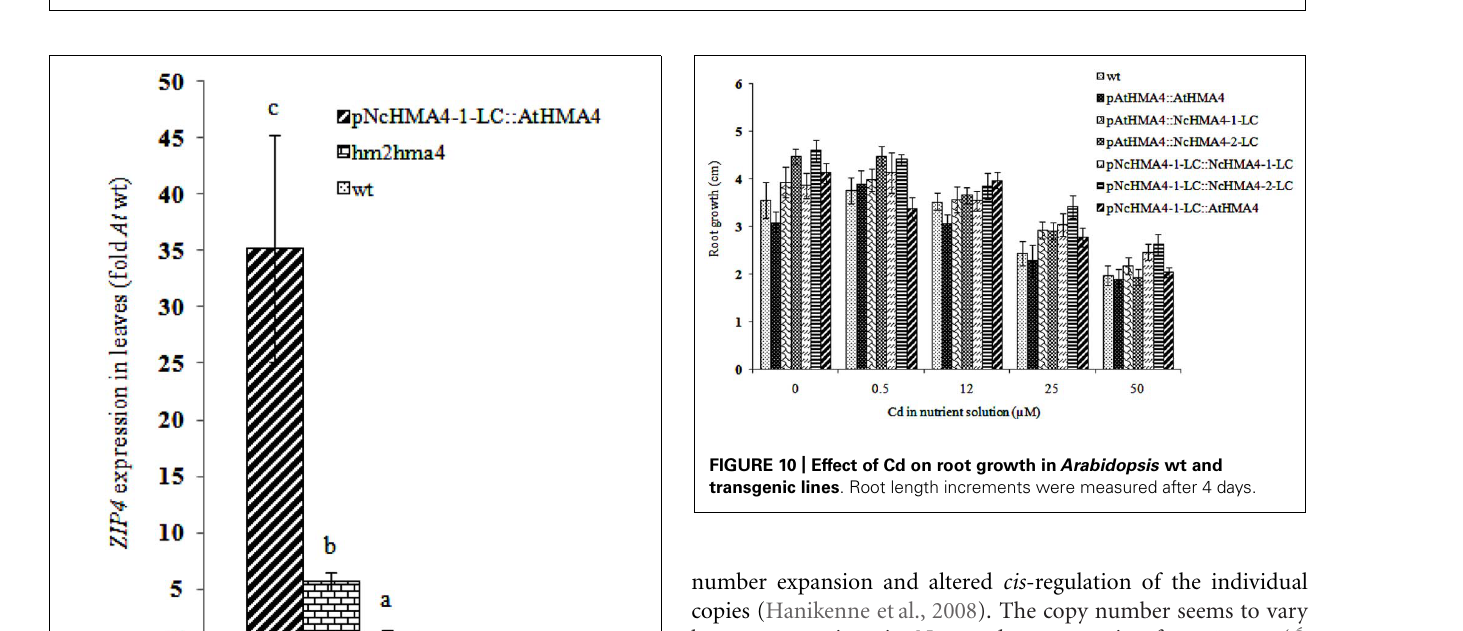
FIGURE 8 | Shoot Zn concentration ( μ mol g − 1 DW) at 2 μ M ZnSO 4 in the nutrient solution in two successive experiments performed with Arabidopsis wt, untransformed hma2hma4 double mutant, and five transgenic lines expressing AtHMA4 under different NcHMA4 promoters